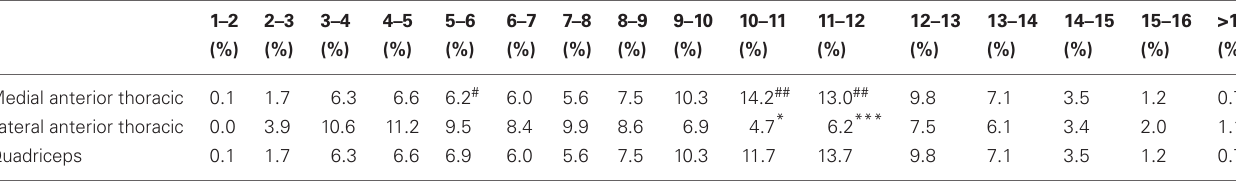
Table 2 | Distribution spectra of myelinated fibers of pectoral and quadriceps nerves.